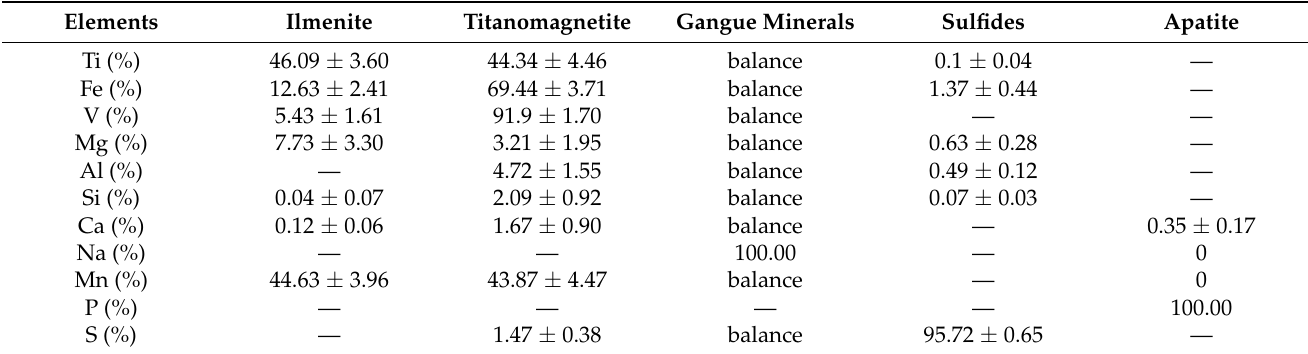
Table 4. Elemental composition of the different minerals present in the